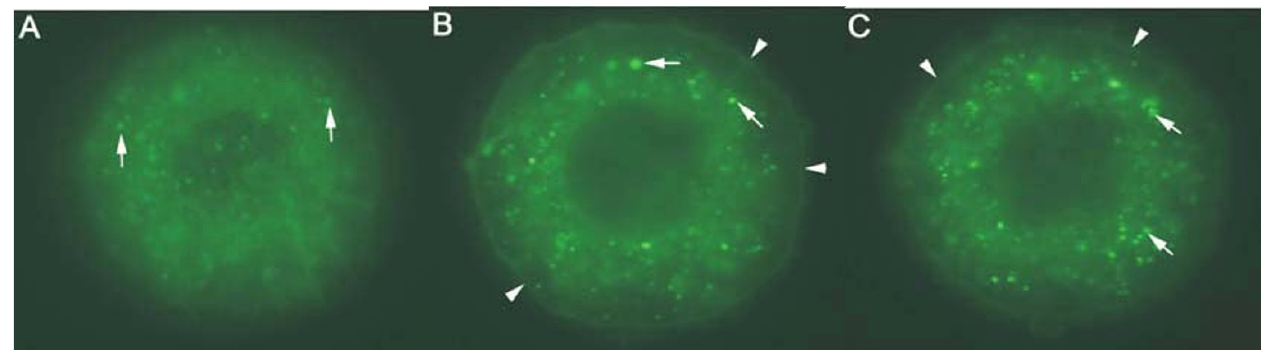
Figure 5 Fluorescence microscopy of S2 cells expressing wild type P0/GFP in three different layers. In all layers, green ves- icles are clearly visible in the cytoplasm. In (B) and (C) the equator of the cells is matched and the green fluorescence of the membrane is visible indicating the functional incorporation of wild type P0-GFP fusion proteins. Arrows indicate wild type P0- GFP in cytosolic vesicles and at the cell surface. The nuclei are free of fluorescence in contrast to the isolated GFP fluores- cence (see fig.